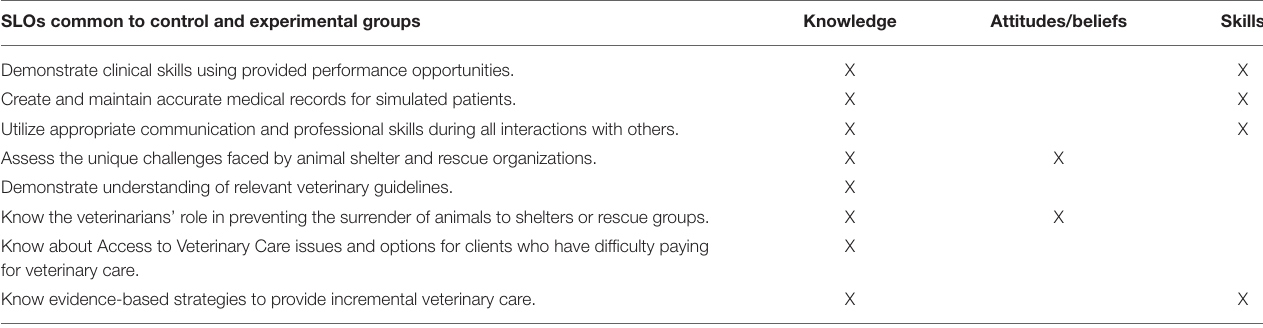
TABLE 1 | Student Learning Objectives (SLOs) associated with the virtual shelter medicine rotation and experienced by all students regardless of their assigned study condition. SLOs common to control and experimental groups Knowledge Attitudes/beliefs Skills